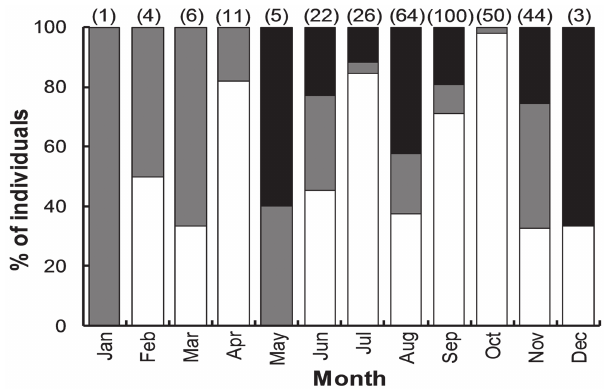
Fig. 5. Monthly percentage of Prochilodus nigricans having three different stomach fullness categories: white = empty, grey = half full, black = full (data combined from males, females and undetermined individuals). Numbers above bars are sample